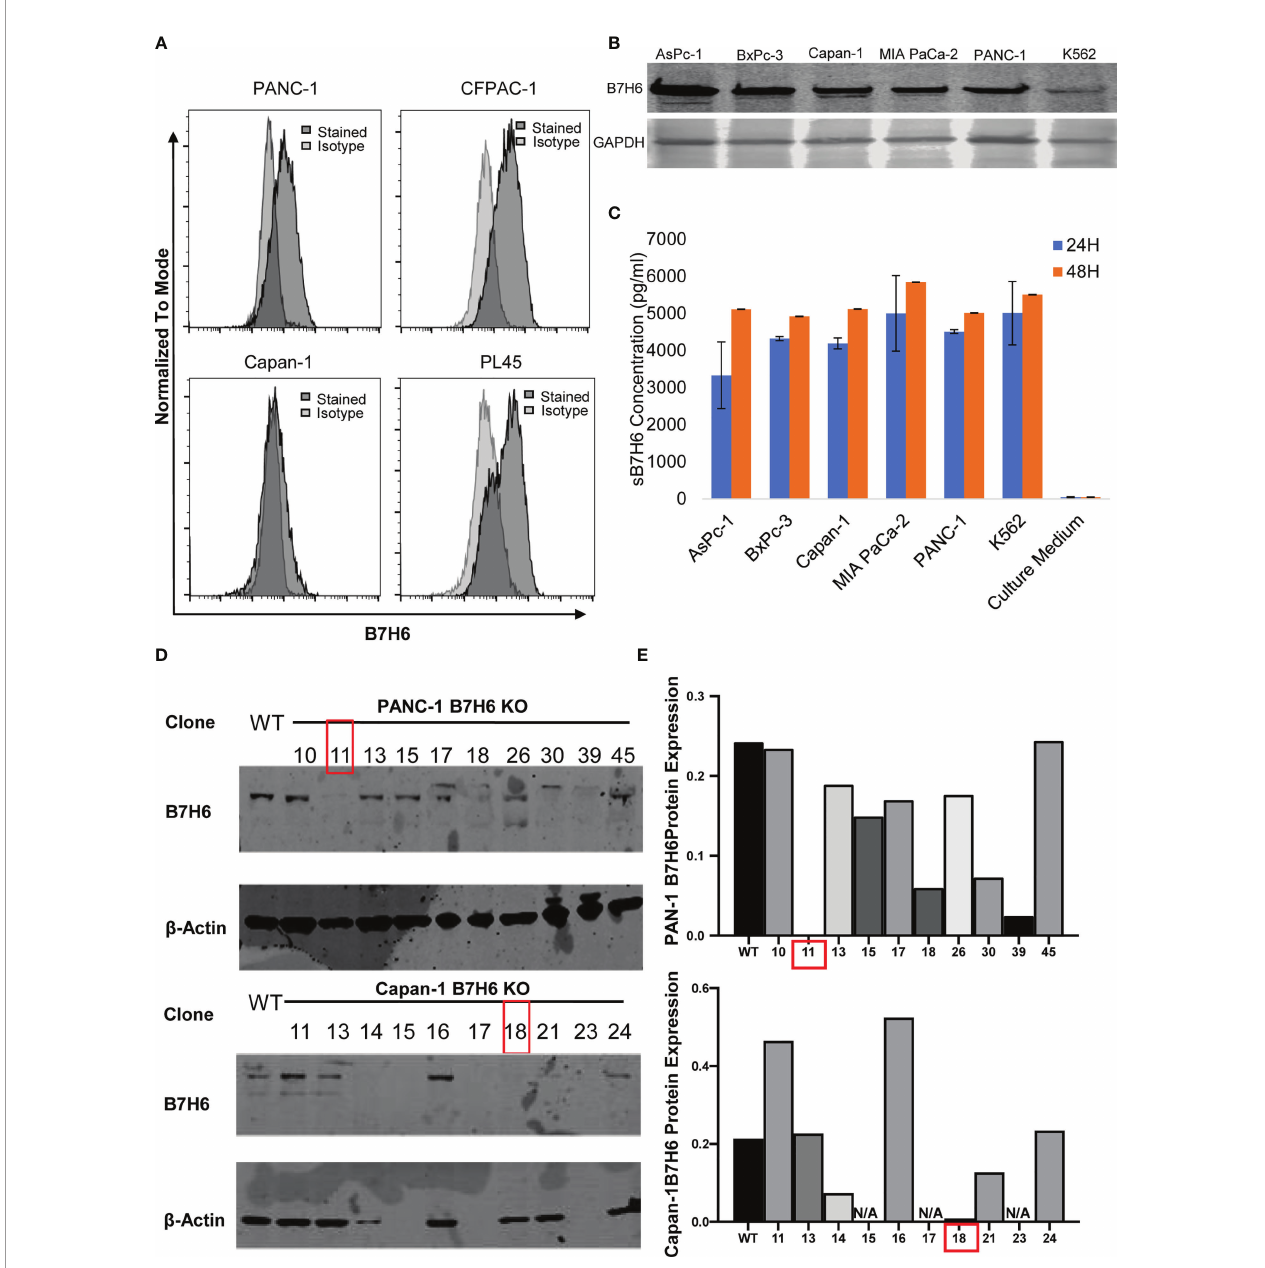
FIGURE 3 | B7H6 expression in human PC cell lines and generation of B7H6 KO PC cell lines. (A) Surface expression of B7H6 on human pancreatic cancer cell lines (PANC-1, CFPAC-1, Capan-1, PL45) was assessed with a Fortessa X20 fl ow cytometer. (B) Immunoblotting detected B7H6 protein expression in human pancreatic cancer cell lines, with K562 as a positive control. GAPDH was used as a loading control. (C) sB7H6 secreted by pancreatic cancer cells into supernatants at 24 and 48 hours was analyzed by ELISA. Medium collected from K562 or RPMI-1640 served as a positive or negative control, respectively. Data from at least 3 independent experiments are shown as mean ± SEM. (D) Immunoblotting detected the protein expression of B7H6 after what was knocked out by CRISPR/Cas9 from PANC-1 and Capan-1 cells. b -actin was the internal control (E) Quanti fi cation of B7H6 protein expression on PANC-1 and Capan-1 cells normalized to b